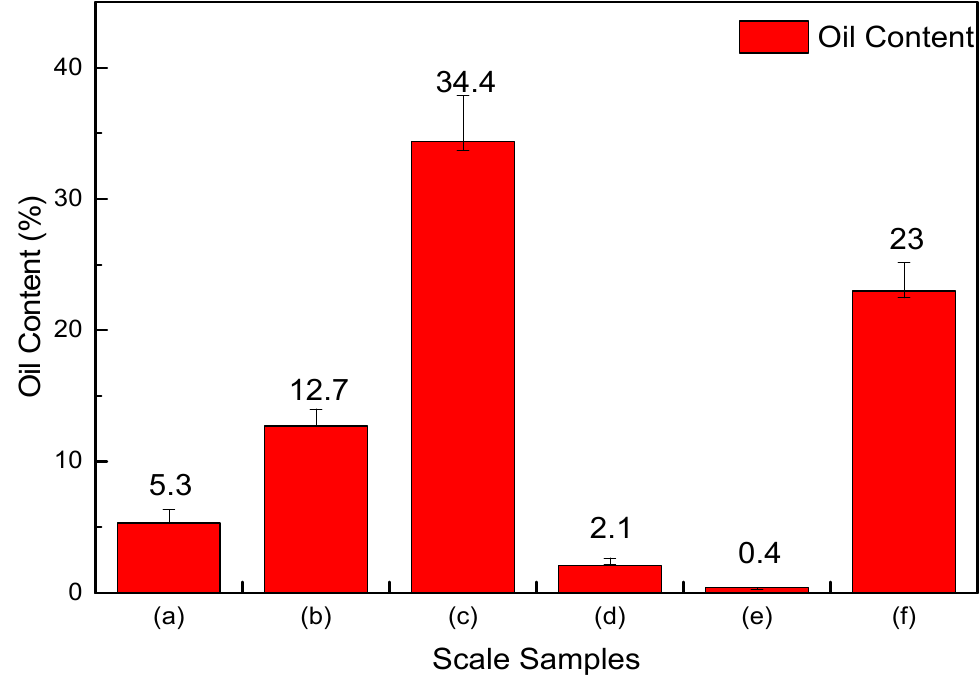
Figure 2. The average oil content of six scale samples.